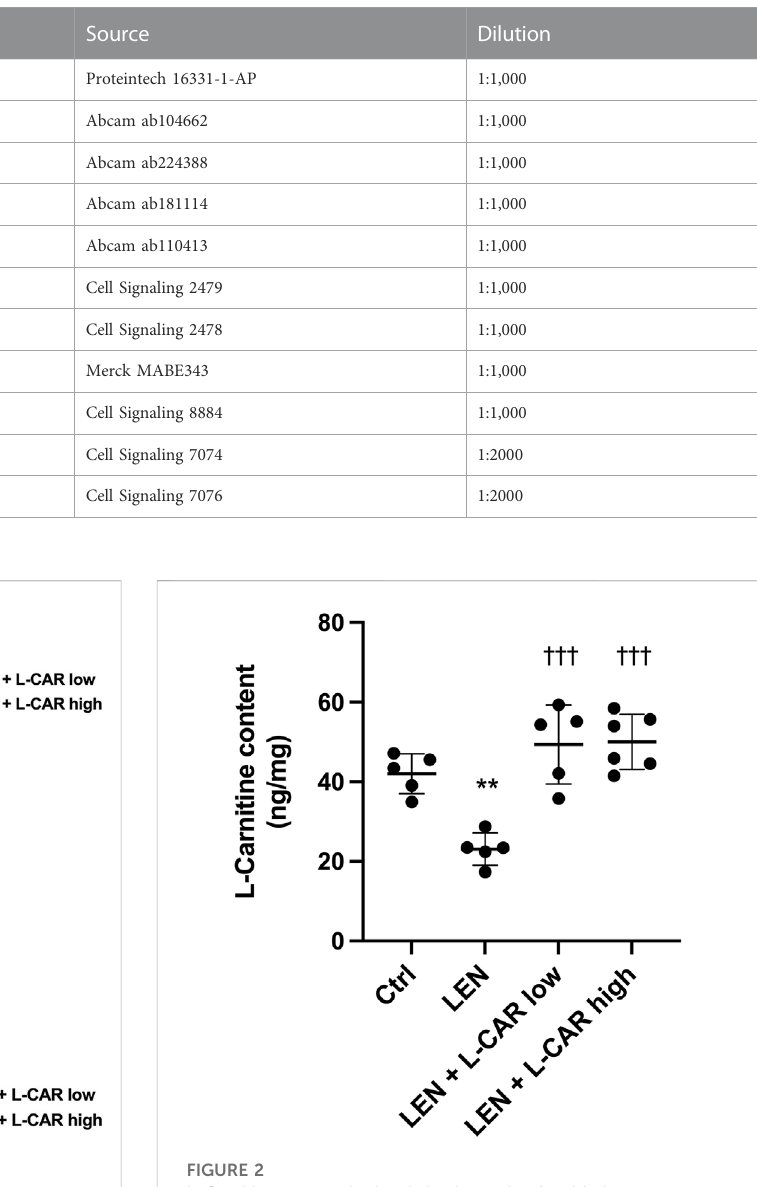
FIGURE 2 L-Carnitine content in the skeletal muscle after 14-day administration of lenvatinib with or without L-carnitine. Data are presented as the mean +SD of experiments in 5 – 6 rats. ** p < 0.01 vs . Ctrl group; ††† p < 0.001 vs. LEN